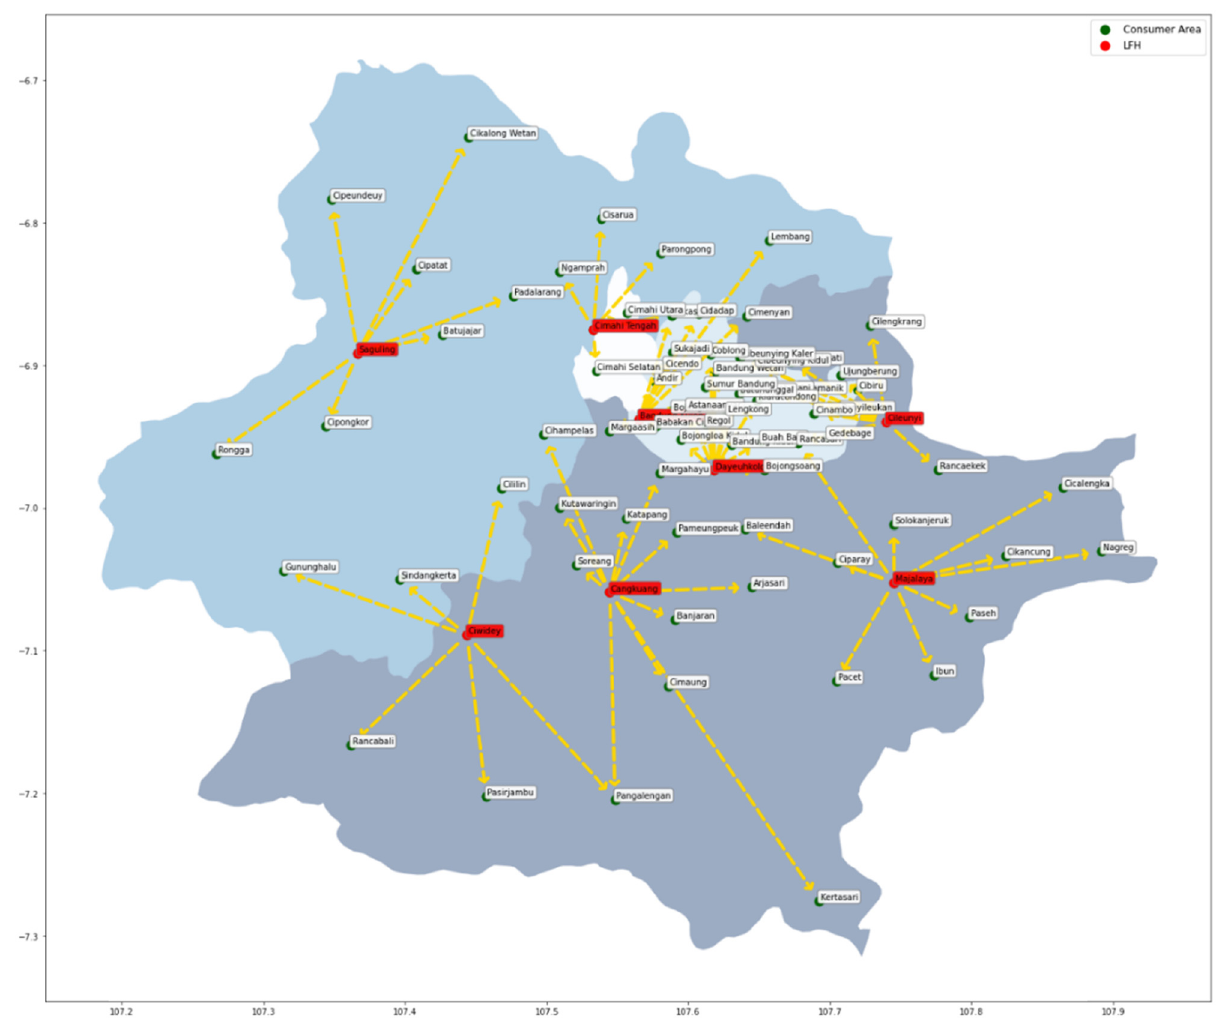
Figure 4: Food network from local food hub to consumer